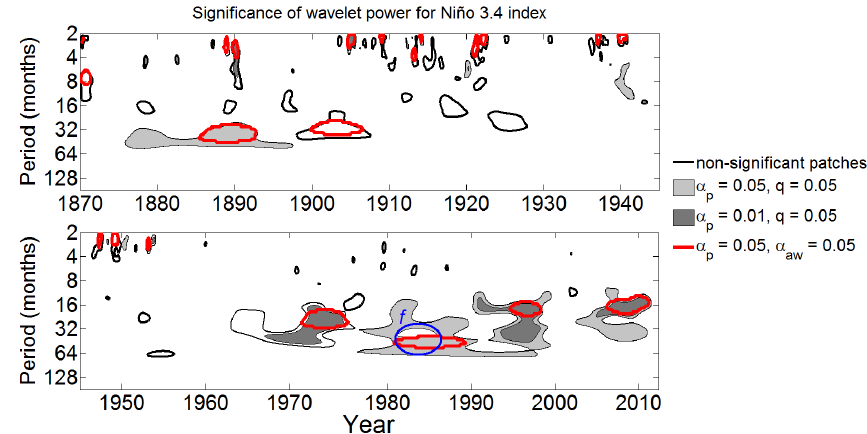
Figure 4. Same as Fig. 3 but for the Niño 3.4 values for the period 1870–2013. The blue curve represents a closed path f that is not contractible to a point because it surrounds a hole (see Sect. 5.1 and Fig.